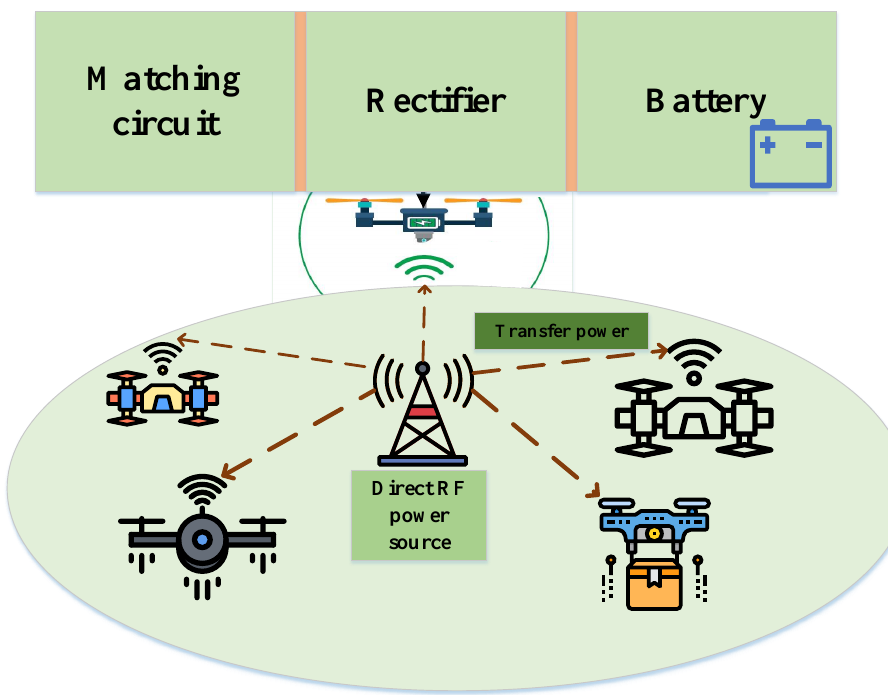
Figure 7. Conceptual block diagram of the far-field WPT